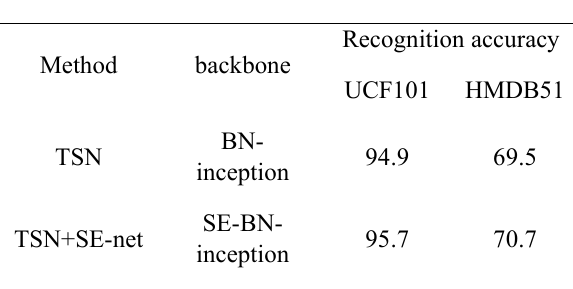
Figure 7. Comparison of recognition accuracy with number of different video segment spatial attention